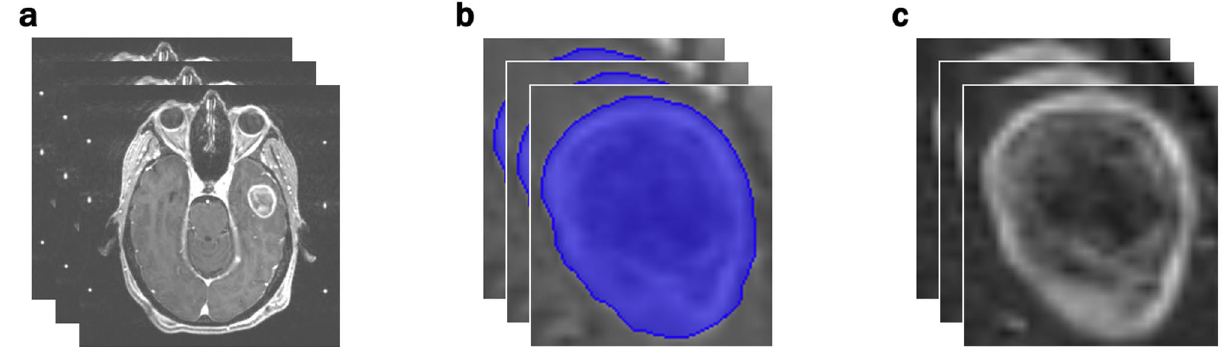
Figure 1. Preprocessing Workflow. ( a ) Input: slices of pre-treatment T1-post contrast brain MRI scans. ( b ) Identification of the region of interest from manual segmentations. ( c ) Output: extracted tumors with pixel resampling, N4ITK bias field correction, and z-score